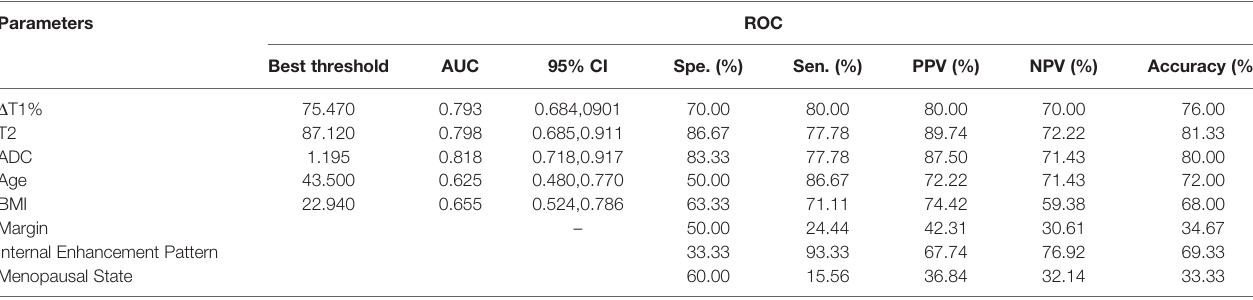
TABLE 4 | Diagnostic performance of different MRI parameters in the diagnosis of breast cancer and benign diseases.